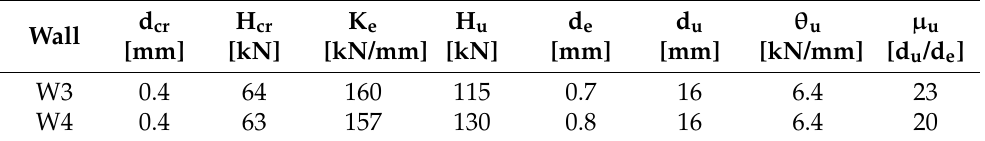
Table 8. Equivalent viscous damping for characteristic limit states of W3 and W4 ( σ v = 0.4 N/mm 2 ). Damping